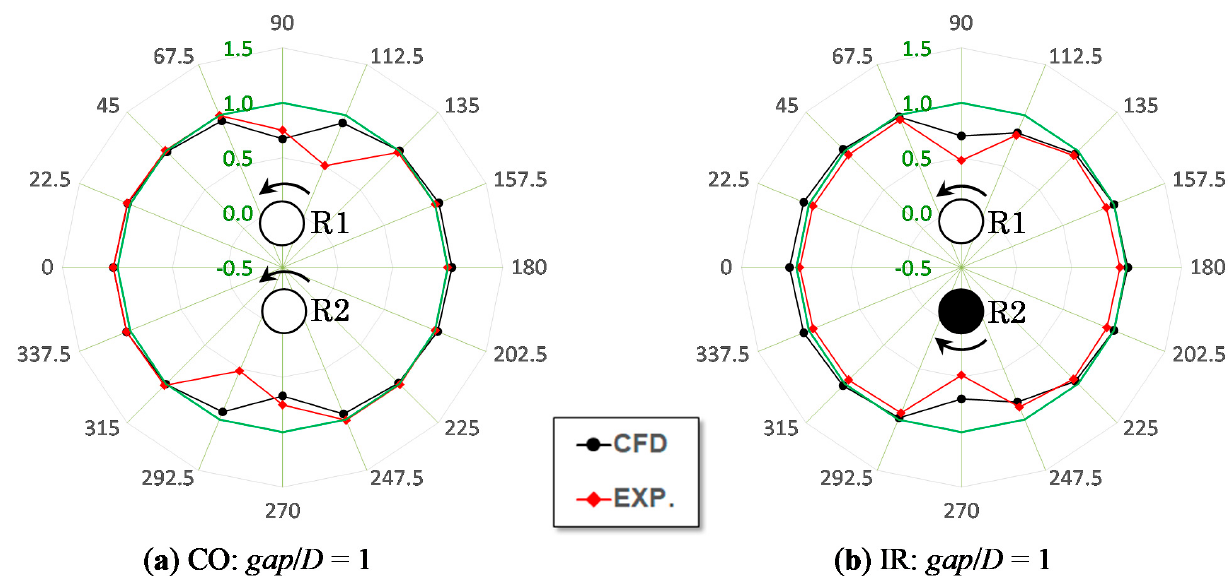
Figure 16. Comparison between CFD and experimental results on 16-wind-direction dependence of normalized mean angular velocity: ( a ) CO configuration, gap / D = 1; ( b ) IR configuration, gap / D = 1.